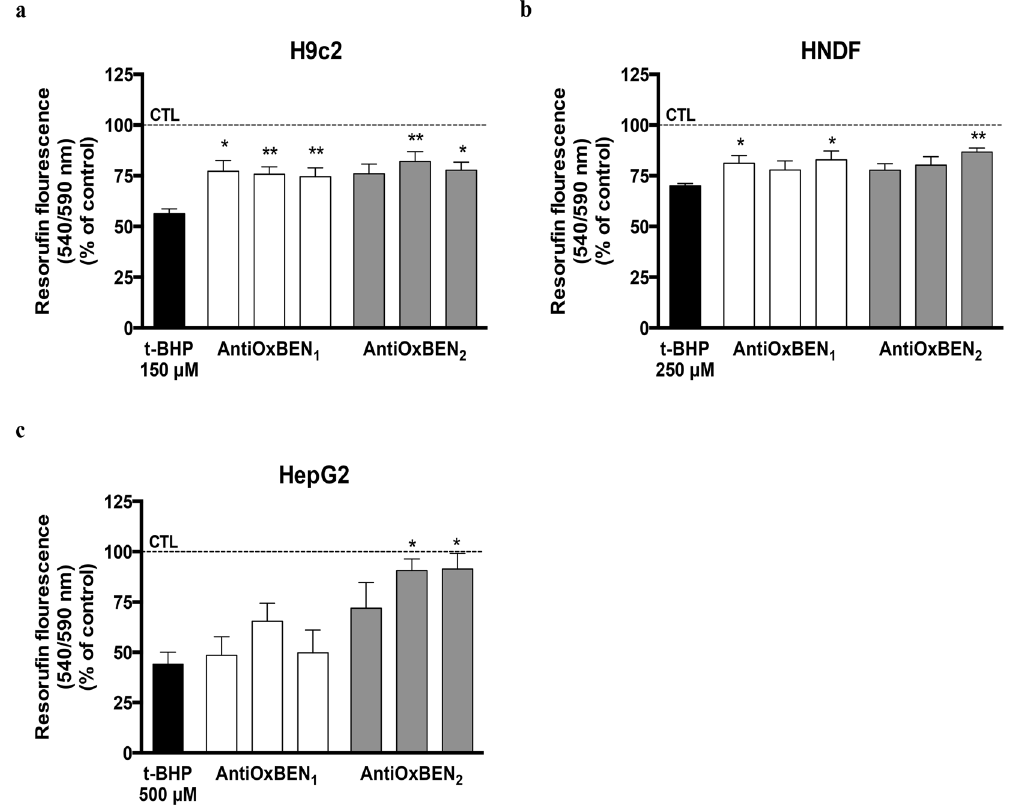
Figure 8. Antioxidant cytoprotective effects of AntiOxBEN 1 and AntiOxBEN 2 on ( a ) rat embryonic cardiomyoblasts (H9c2), ( b ) human neonatal dermal fibroblasts (HNDF) and ( c ) human hepatocellular carcinoma (HepG2) cells against t-BHP-induced metabolic activity decrease. Each compound has three bars, which corresponds to the different concentrations used (from left to right, 25, 50, 100 µ M).The comparisons were performed by using one-way ANOVA between the control (t-BHP) vs. preparation where AntiOxBENs were pre-incubated. Data are means ± SEM of four independent experiments and the results are expressed as percentage of control (control = 100%), which represents the cell density without any treatment in the respective time point. Significance was accepted with * P < 0.05, ** P < 0.01, *** P < 0.0005, **** P <